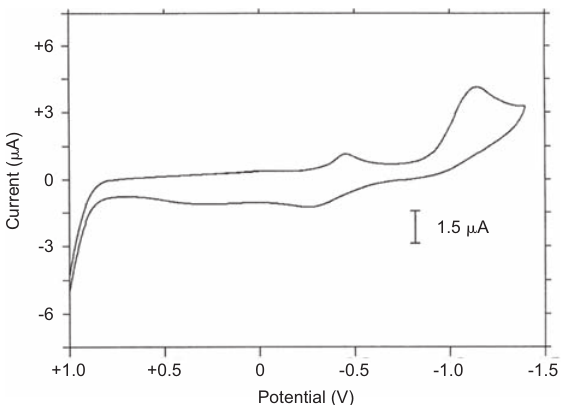
Figure 3 Cyclic voltammogram of [Cd(L)( µ -Cl)] in 0.1 M TEAP-DMSO solution at 20.0 ± 0.1 ° C. The scan rate